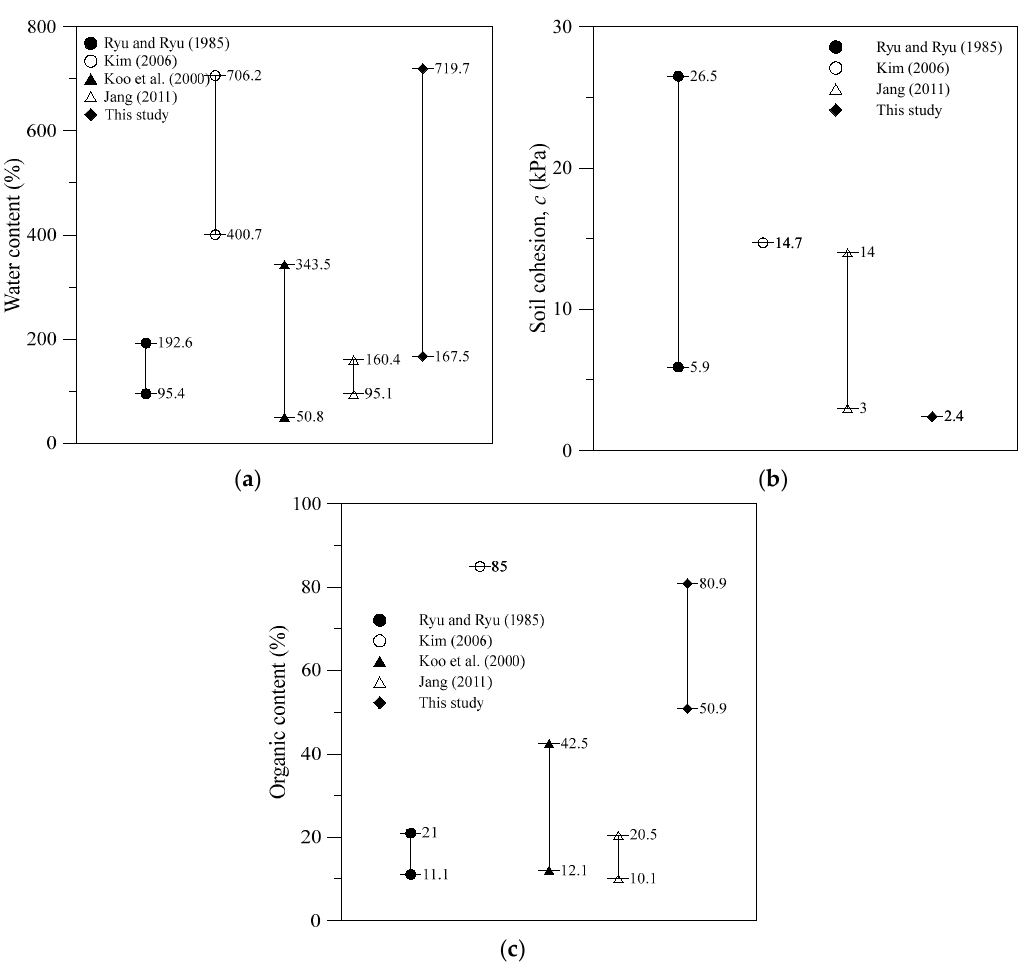
Figure 3. Properties of organic soil: ( a ) Water content; ( b ) soil cohesion; ( c ) organic content.